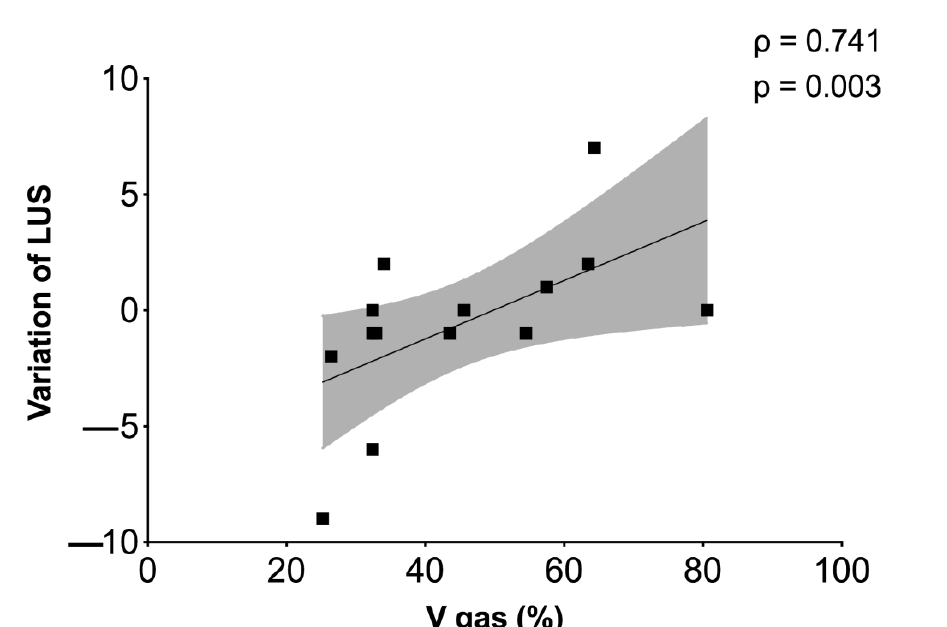
Figure 5. Correlation between LUS and CT scan. Correlation between the volume of gas and hyper- aeration at CT scan and the difference between the first (baseline) and the second (immediately after RPT) LUS have been identified.